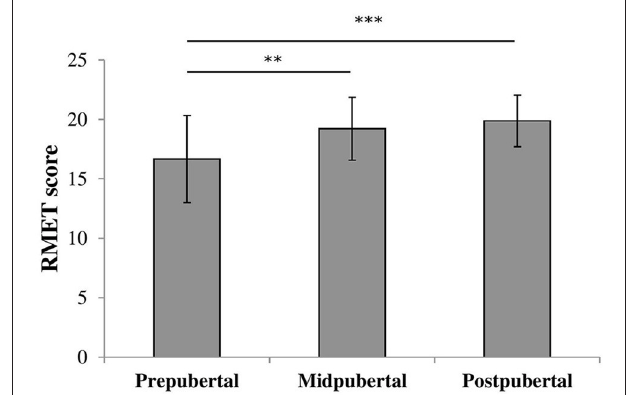
FIGURE 2 | Bars shown represent total RMET score per pubertal group, error bars show the standard deviation from the mean. Data showed a main effect